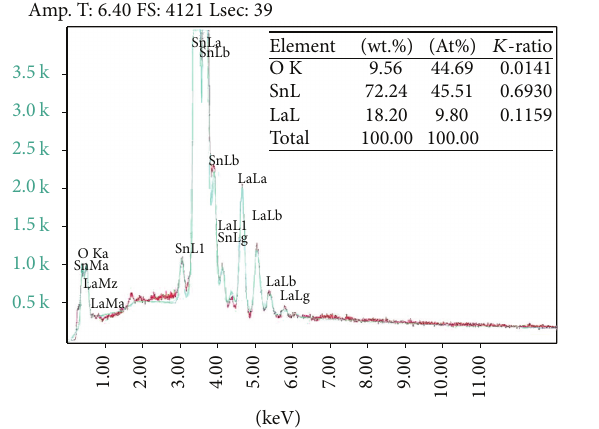
Figure 15: Point analysis of sharp-edged lanthanum particle.